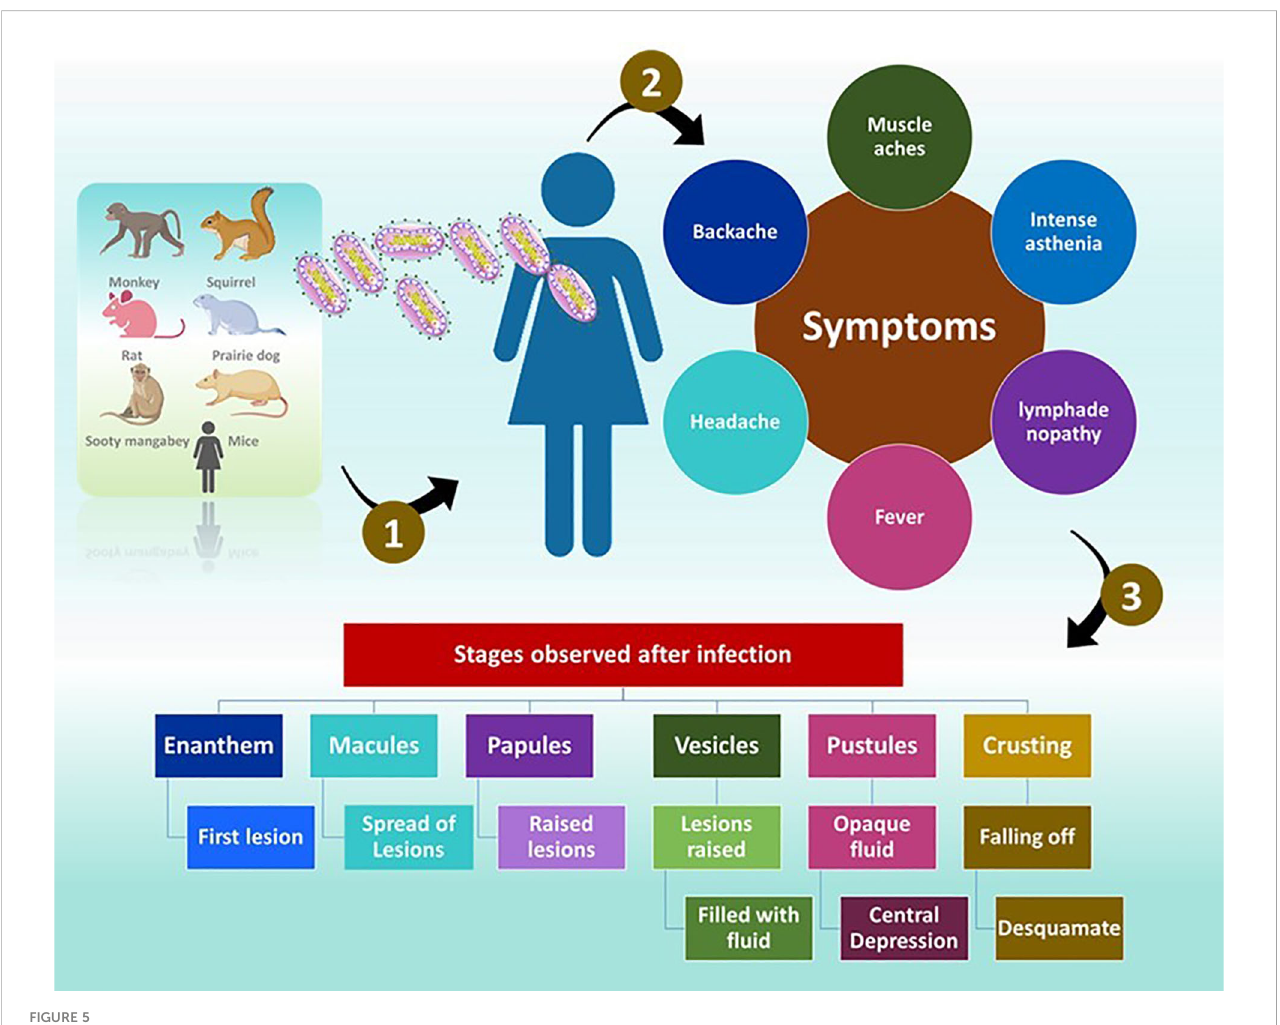
FIGURE 5 Infection with MPV. The symptoms and different stages observed in an infected